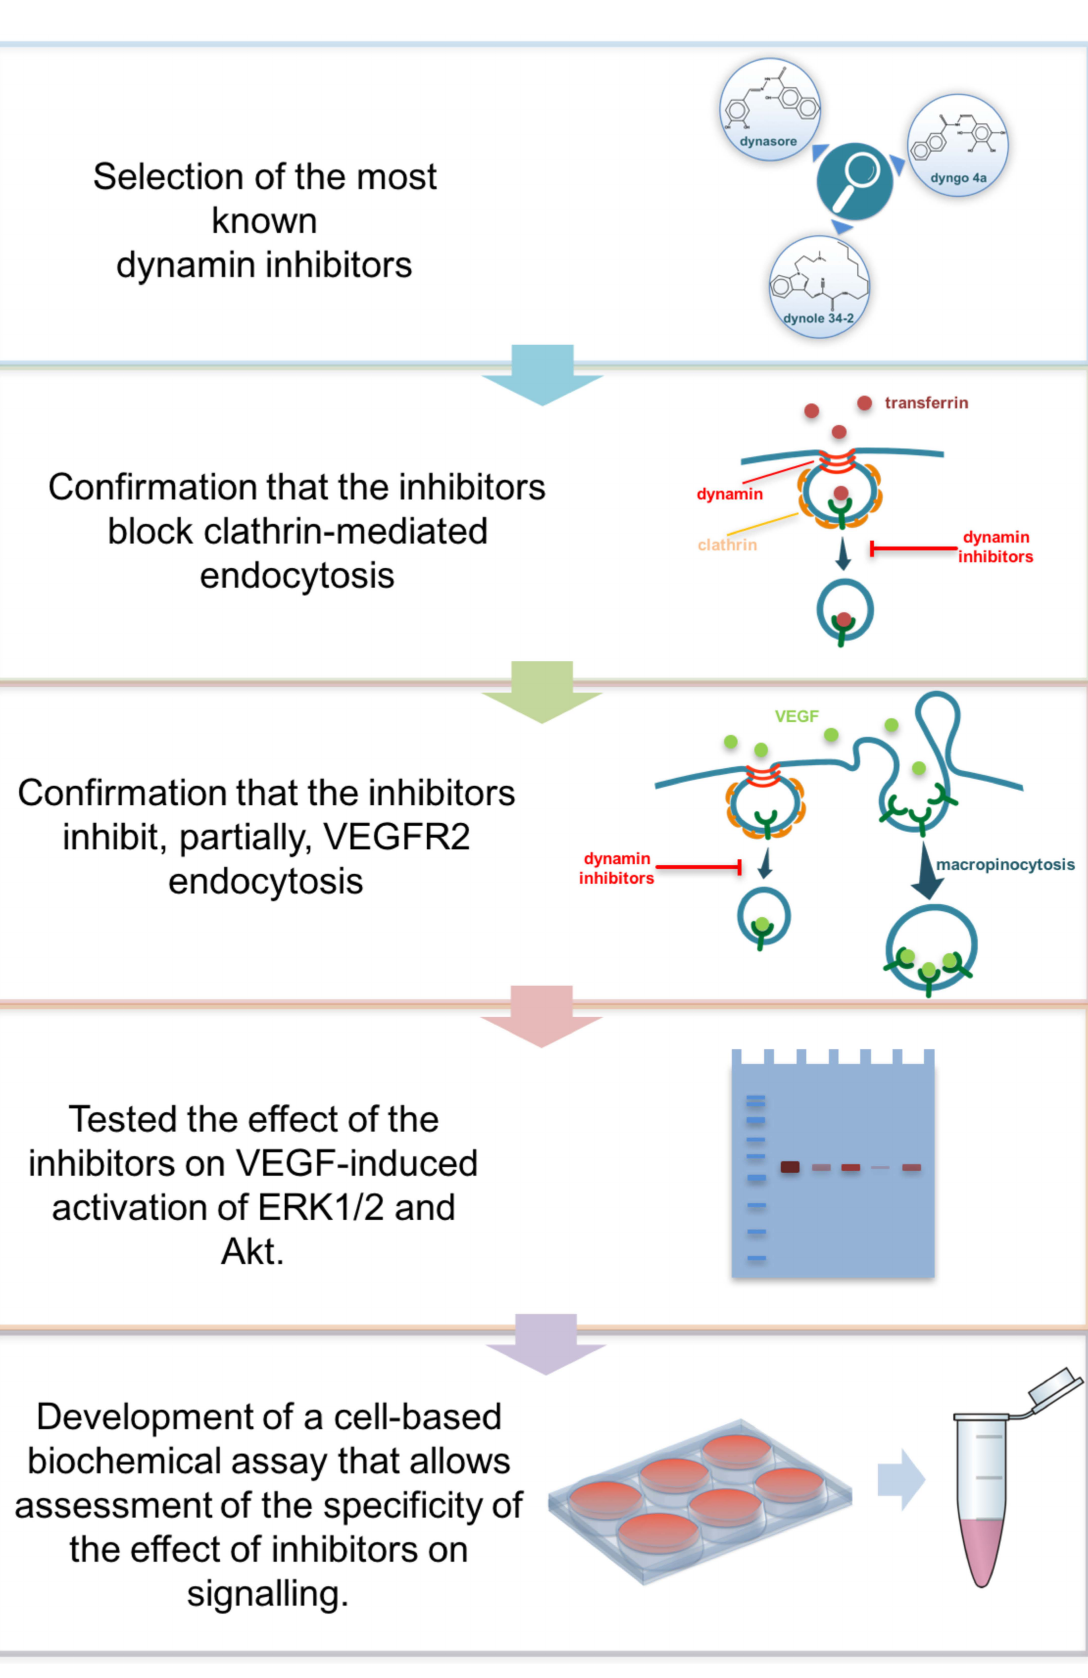
Figure 1. Overview of the workflow of this study. The figure outlines the experimental workflow used in the present